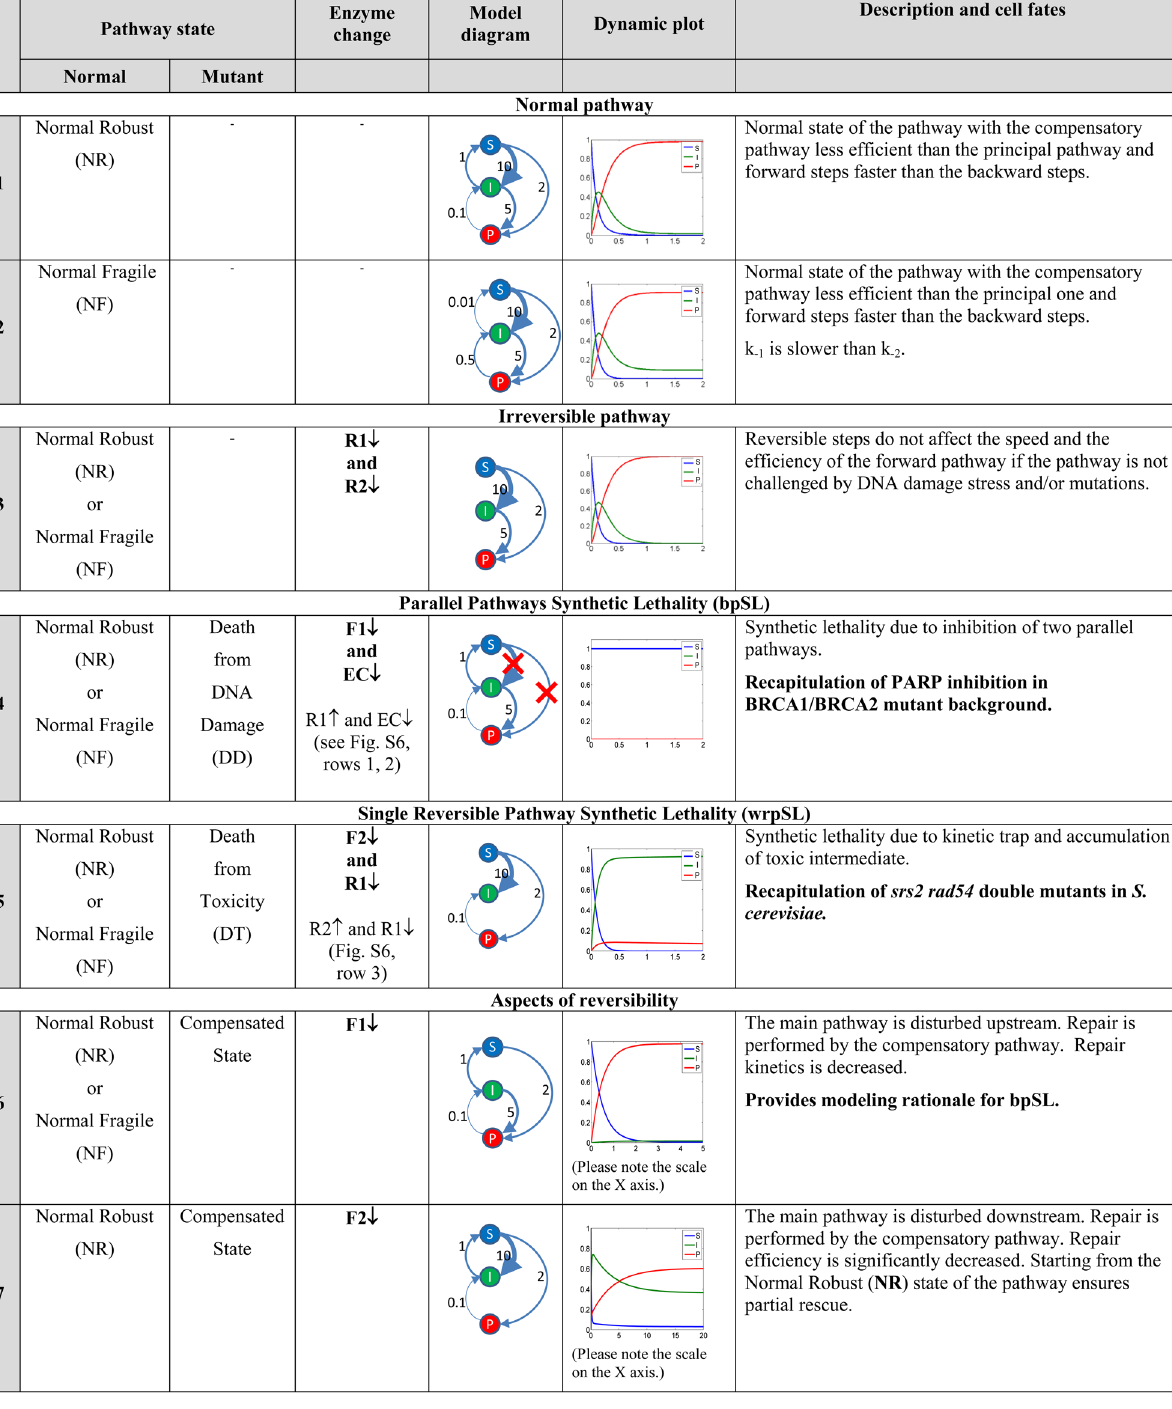
PLOS Computational Biology |